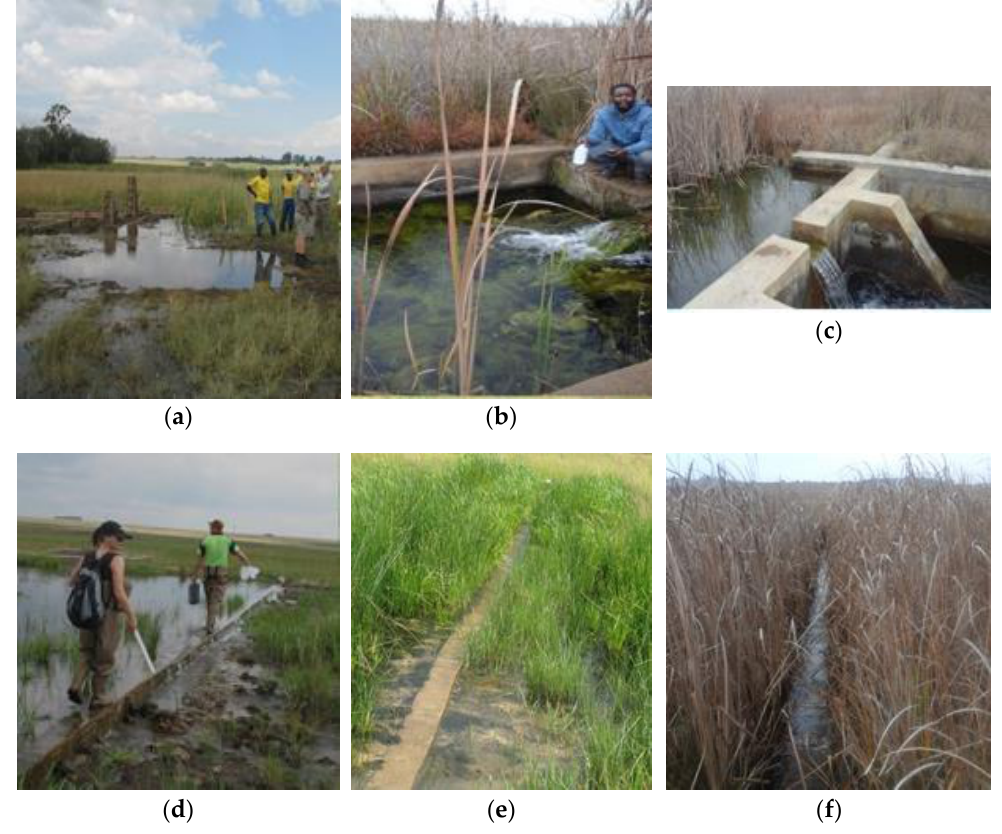
Figure 2. ( a – d ). Concrete structures built in the wetland to regulate and reduce the flow. ( e , f ). Revegetation of the enlarged wetland area in 2015.